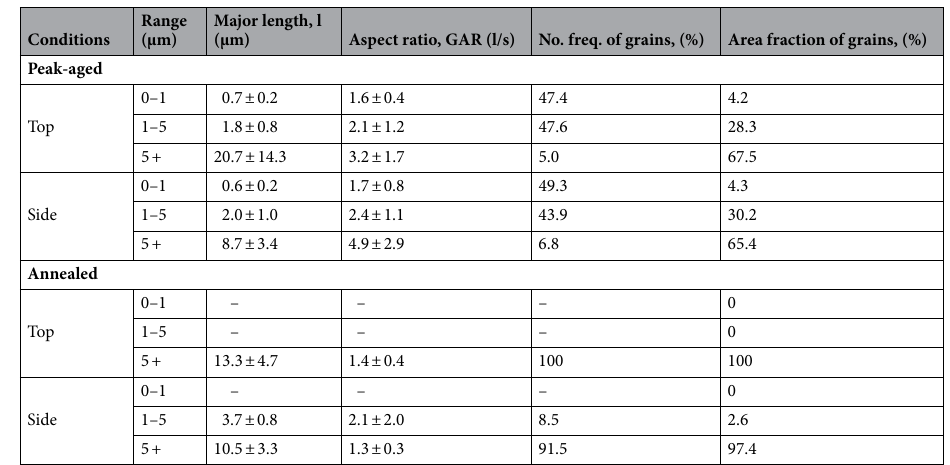
Table 1. SEM grain morphology for peak-aged and annealed